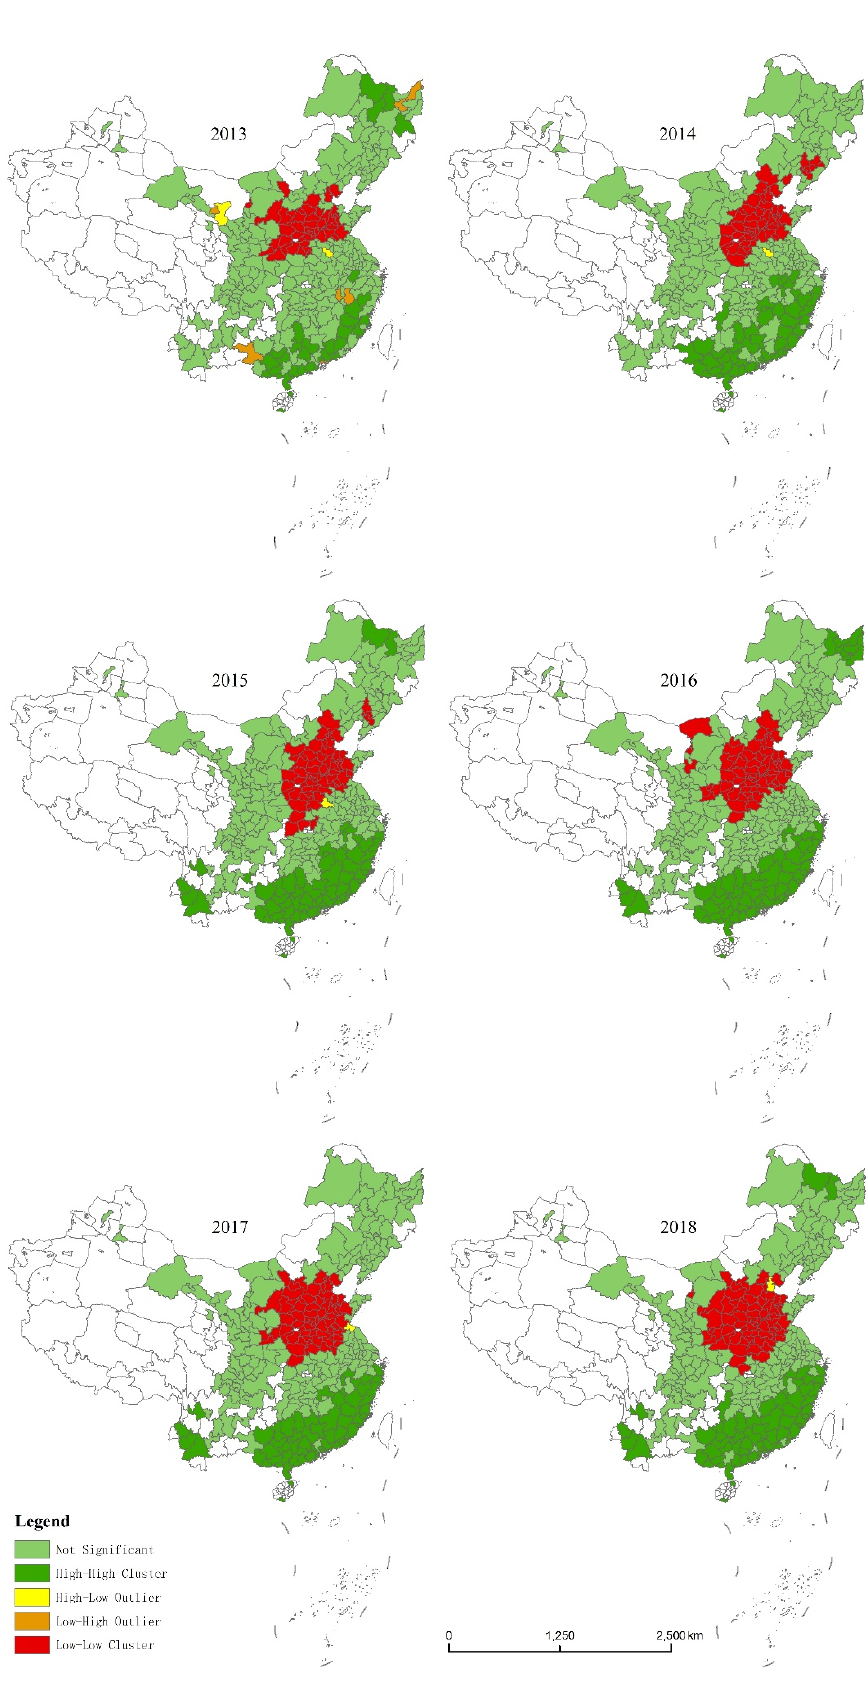
Figure 6. Anselin Local Moran’s I map of human settlements in China from 2013 to 2018.